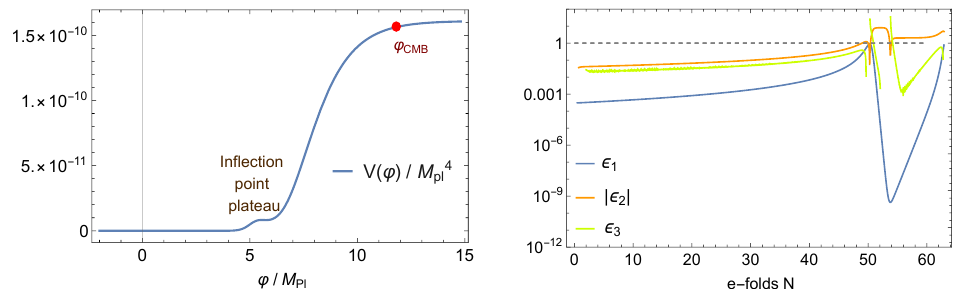
Figure 7. In the left panel the potential of a runaway inflaton field described by superconformal attractors is depicted. The inflaton field value corresponding to the CMB scale k = 0.05 Mpc − 1 is denoted with a red dot. In the right panel the Hubble flow parameters (cid:101) 1 , (cid:101) 2 , (cid:101) 3 with respect to the e-folds number are depicted demonstrating the slow-roll violation that enhances the power spectrum at the end of the inflationary stage.